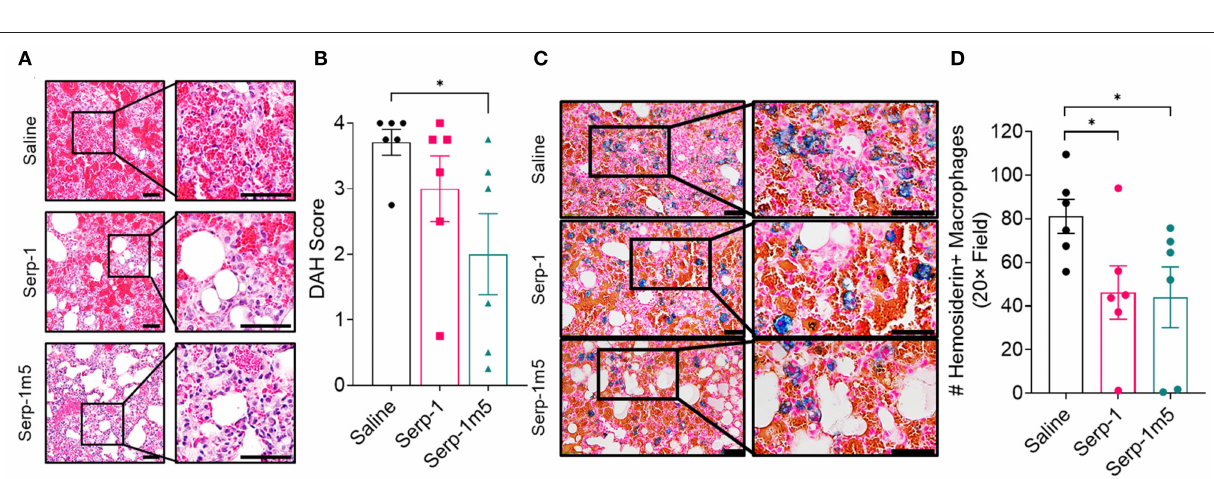
FIGURE 2 | Histological analysis of DAH during treatment with saline control ( N = 6 mice), GMP Serp-1 ( N = 6 mice), or Serp-1m5 ( N = 6 mice) proteins given daily. (A) Representative micrograph images of H&E stained lung sections at 14 days follow up. (B) DAH scores were evaluated by taking four 20 × field of each section, and calculating the average score as standardized: 0, no hemorrhage; 1, 0–25% hemorrhage; 2, 25–50% hemorrhage; 3, 50–75% hemorrhage; 4, 75–100% hemorrhage. The DAH score of Serp-1m5 is significantly lower than that of the saline group ( p = 0.0252). (C) Representative micrographs of Prussian blue staining at 14 days for each treatment group. (D) Both Serp-1 ( p = 0.0370) and Serp-1m5 ( p = 0.0424) significantly reduced detected hemosiderin laden macrophage counts in lungs form the pristane induced DAH model. * p <